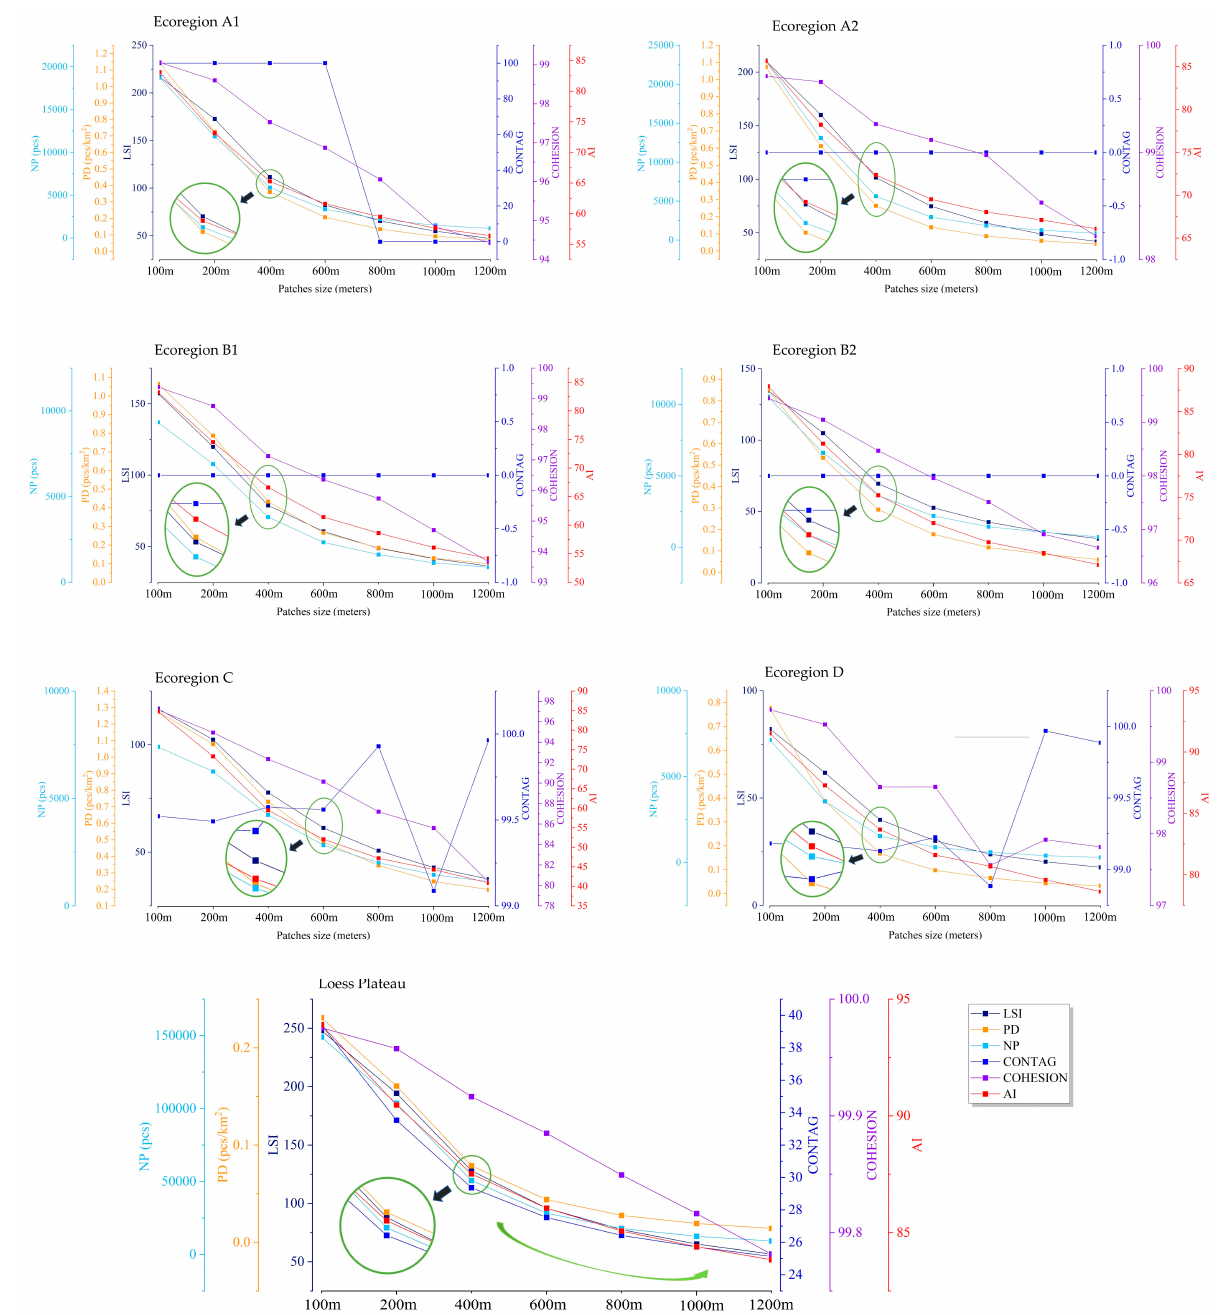
Figure 4. Landscape Pattern Index of the Loess Plateau and all ecoregions.